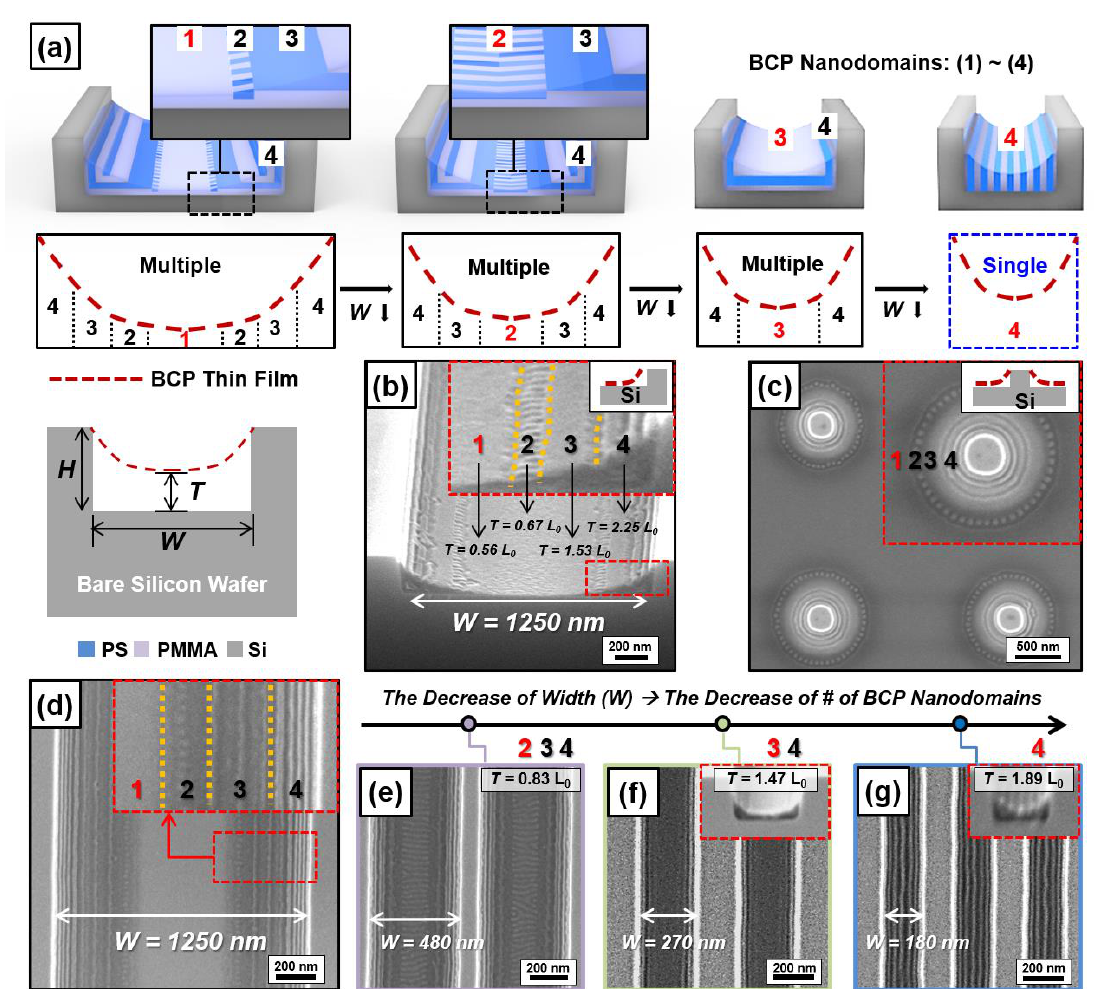
Figure 1. Evolution of the multiple orientations of a lamella-forming block copolymer (BCP) nanodomain inside a bare silicon trench with different widths. ( a ) Schematic illustration of the evolution of multiple orientations of lamella-forming BCP nanodomains. Top-view SEM images of BCP (PS- b -PMMA, M n = 44 – 45 kg/mol) nanodomains ( b ) inside a silicon trench (W = 1250 nm) and ( c ) silicon pillar array. ( d – g ) Top-view SEM images of the evolution of multiple orientations of lamella-forming BCP nanodomains (PS- b -PMMA, M n = 25 – 26 kg/mol) inside a silicon trench (W = 180 – 1250 nm).